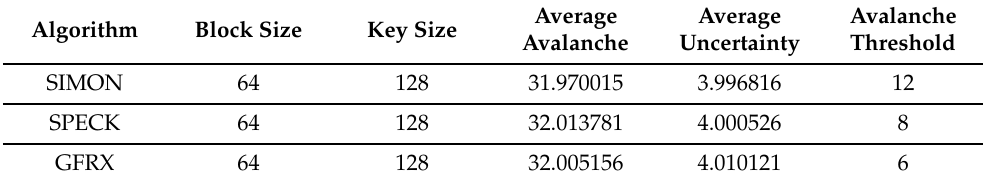
Figure 9. The average avalanche degree of SPECK64/128. Table 2. Comparison of avalanche effect among structural